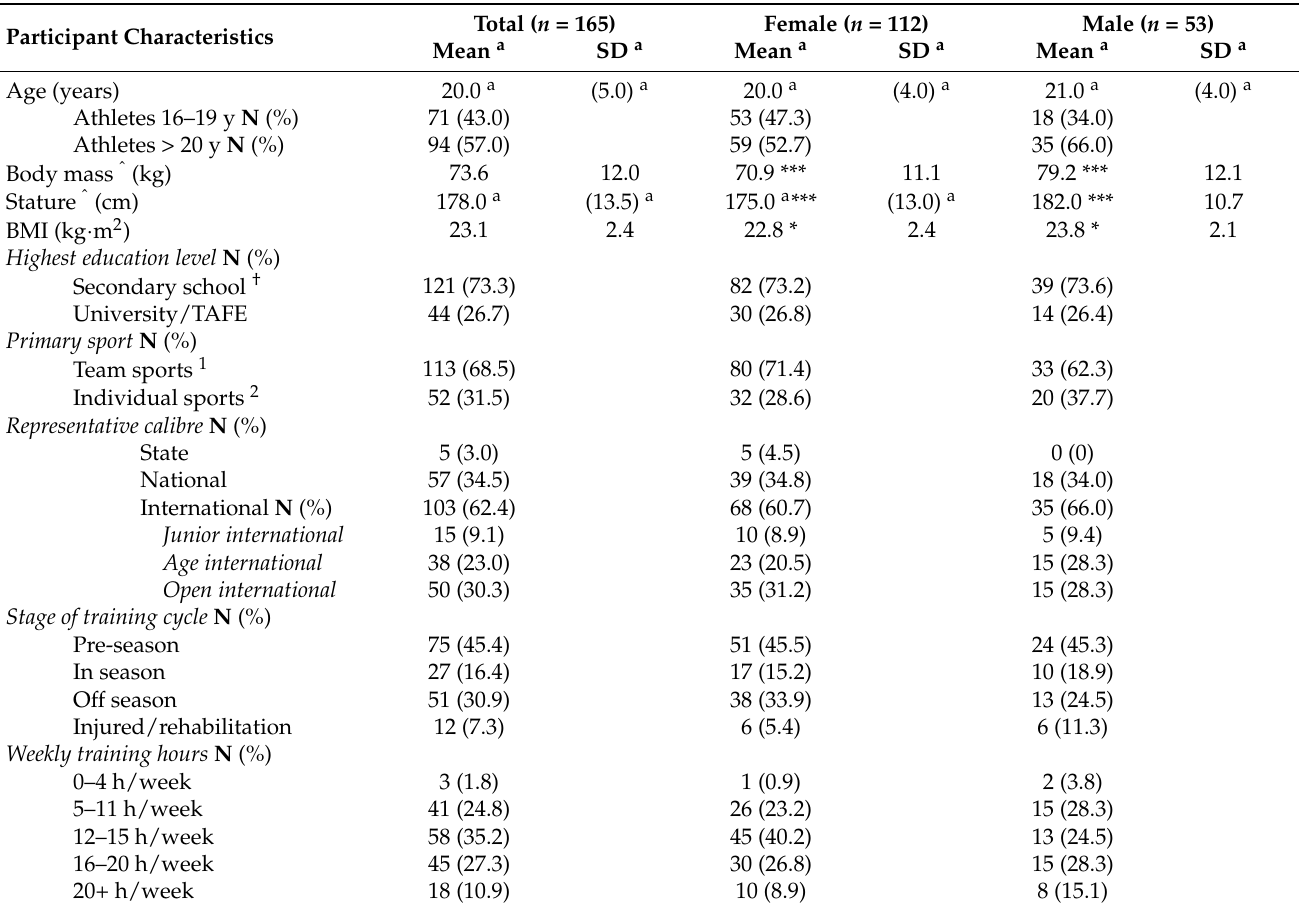
Table 1. Athlete demographic and sports-specific